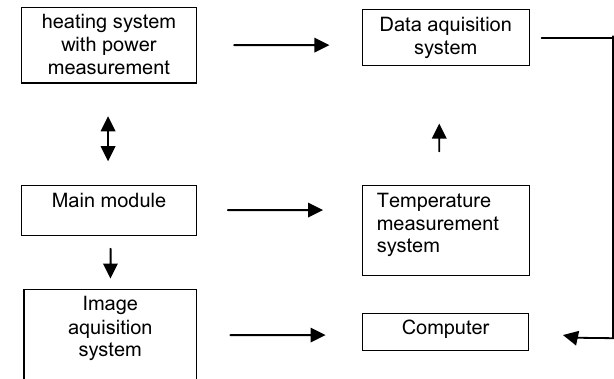
Figure 7. Scheme of the testing